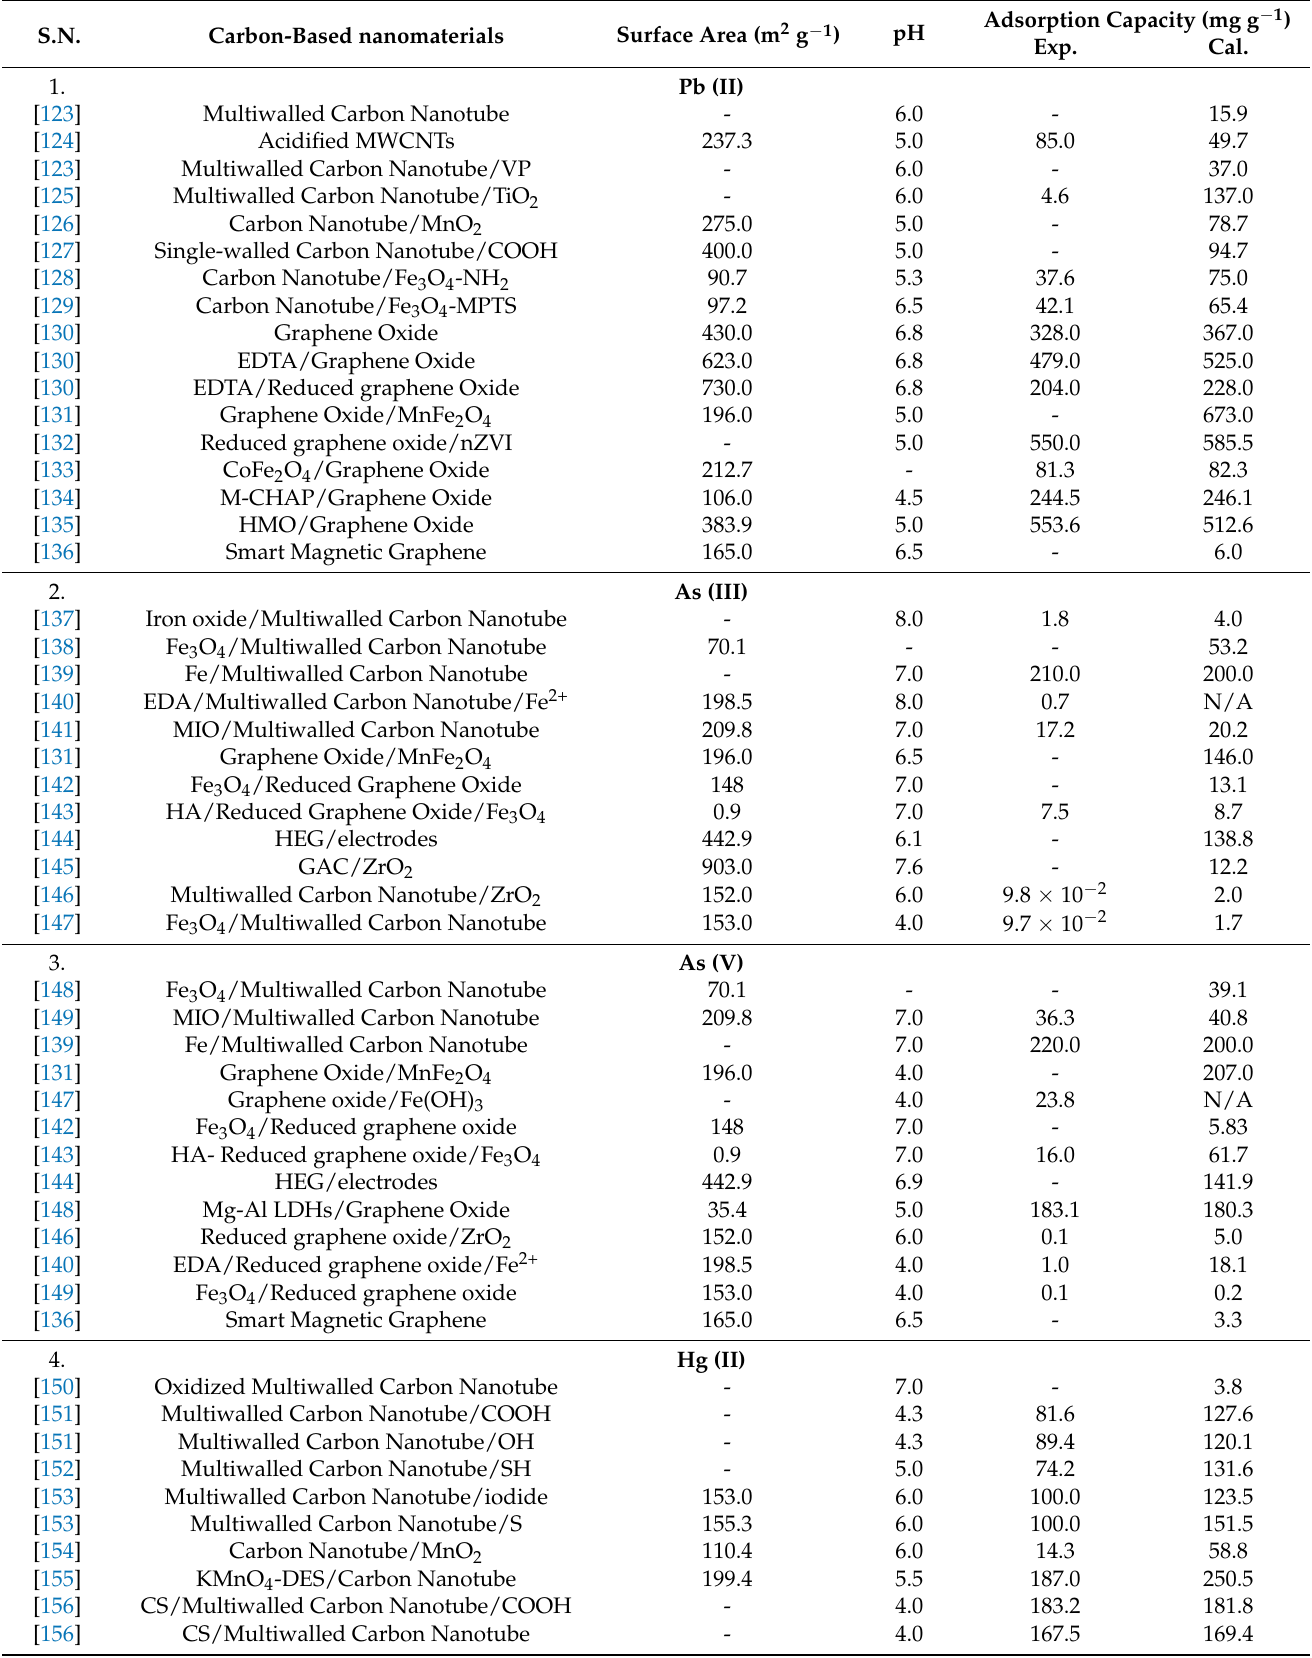
Table 4. Aqueous toxic heavy metal adsorption by functionalized carbon-based nanomaterials.